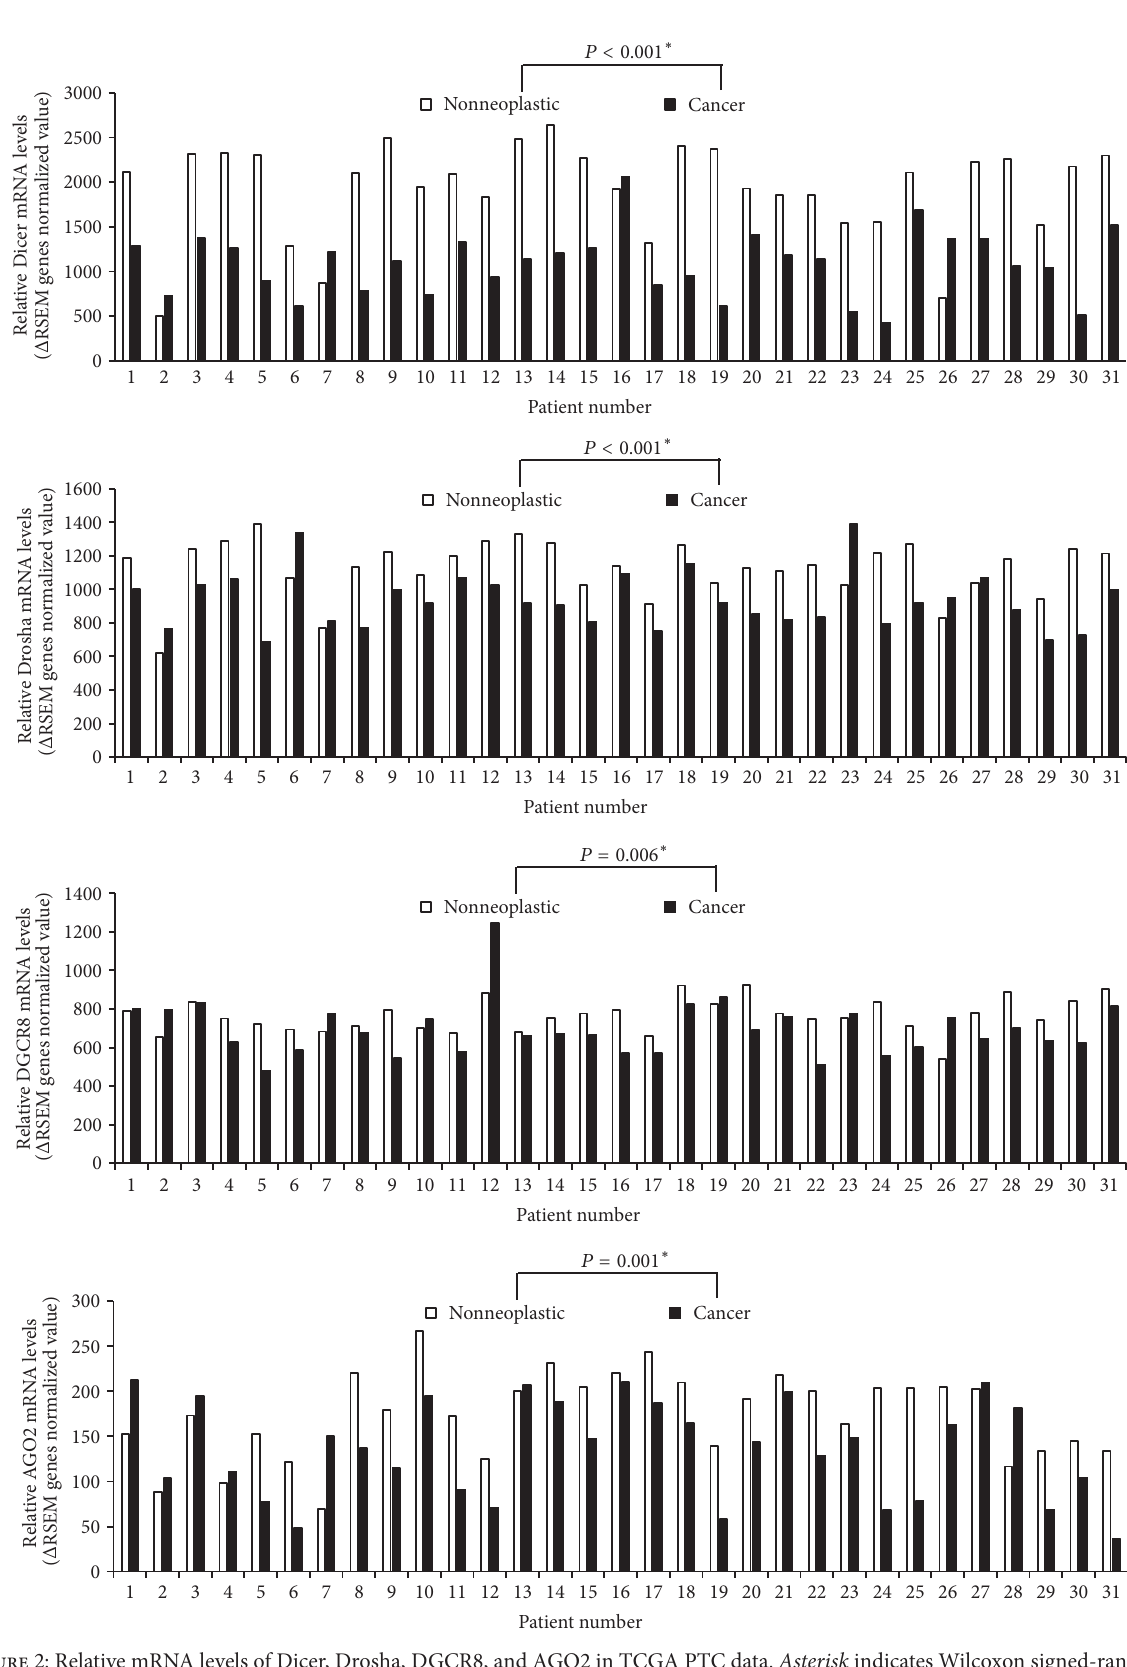
Figure 2: Relative mRNA levels of Dicer, Drosha, DGCR8, and AGO2 in TCGA PTC data. Asterisk indicates Wilcoxon signed-rank